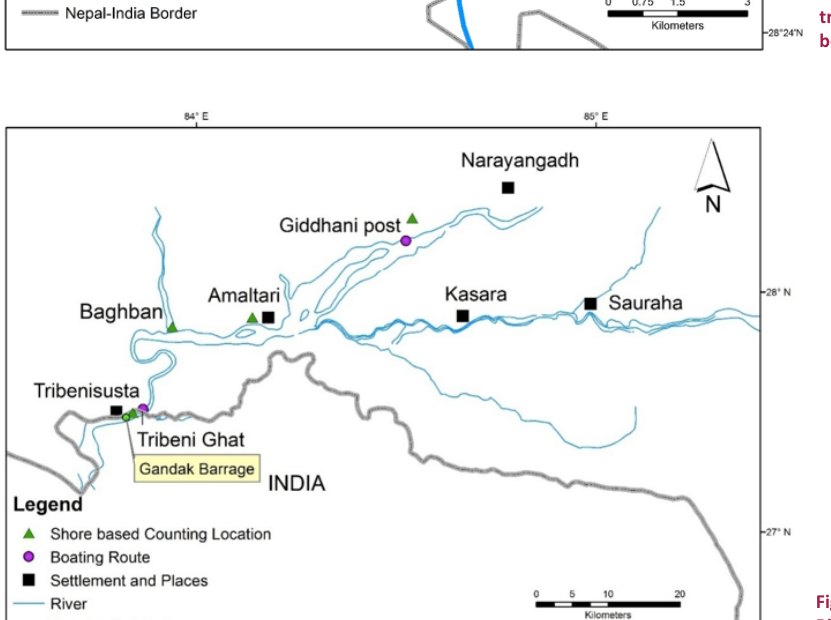
Figure 3. The surveyed areas in Mohana and its tributaries. Mohana is a right tributary of Karnali River. The Nepal-India border shown in this figure is not in scale.